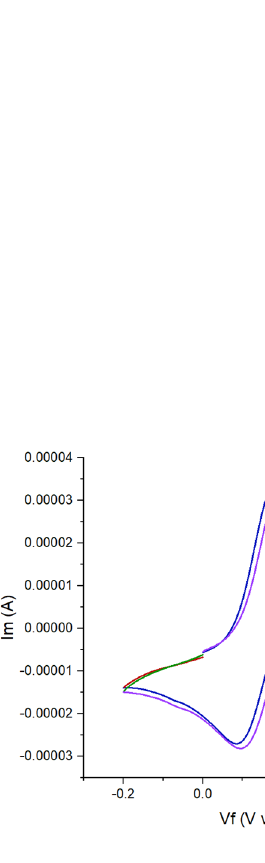
Figure 9. CV of the gold and platinum electrodes before and after electrochemical cleaning: blue/red-CV before cleaning; purple/green-CV after cleaning. Created with OriginPro .